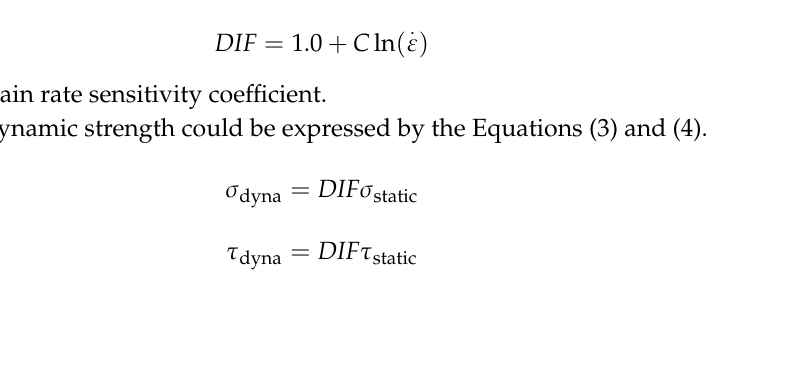
Figure 3. Rate-dependent TSL for shear direction.